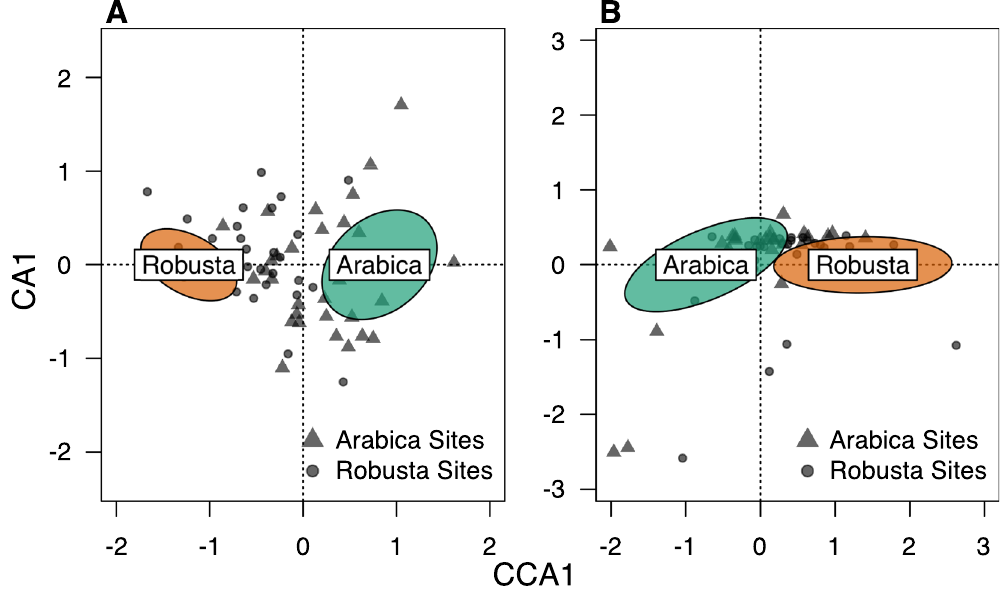
Figure 3. Community composition of ( A ) Forest Dependent birds and ( B ) Endemics across arabica and robusta agroforests. Ordination scores were calculated at the level of farms for each set of species using correspondence analysis. The 95% confidence ellipses for the arabica and robusta site centroids are shown in green and orange, respectively.